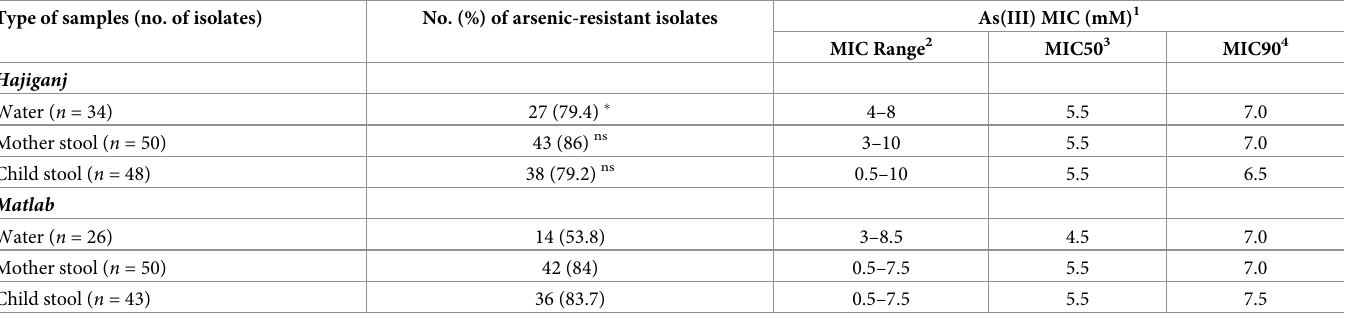
1 MIC of As(III) was determined by micro broth dilution method as described in the Methods section. 2 Range of MIC (mM) of all isolates tested. 3 MIC50 indicates the minimum inhibitory concentration required to inhibit the growth of 50% of bacterial isolates. 4 MIC90 indicates the minimum inhibitory concentration required to inhibit the growth of 90% of bacterial isolates. � indicates statistical significance ( p < 0.05) for the number of isolates resistant to arsenic in Hajiganj compared to Matlab, ‘ns’ indicates non-significant.